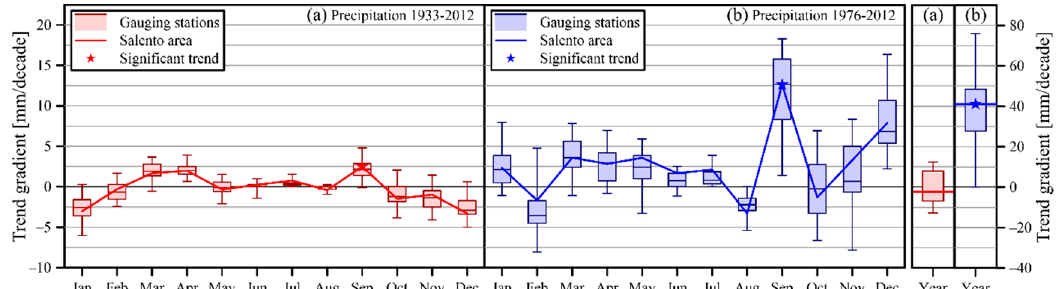
Figure 4. Monthly and annual precipitation trend gradients as evaluated by the Theil-Sen estimator: ( a ) whole period 1933–2012; ( b ) shorter period 1976–2012. The box-whisker plots represent the variability between the 30 rain gauges (the whiskers indicate the minimum and maximum values); the solid line depicts the trend gradient for the whole Salento area with an indication of its significance (95% confidence level). Table 2. Monthly and annual trend gradients, β as evaluated by the Theil-Sen estimator (precipitation, [mm/decade], number of rainy days [rainy days/decade]) and trend significance, at 95% confidence level, S (0, no trend, 1, trend exists) for the Salento area: whole period 1933–2012 and shorter period